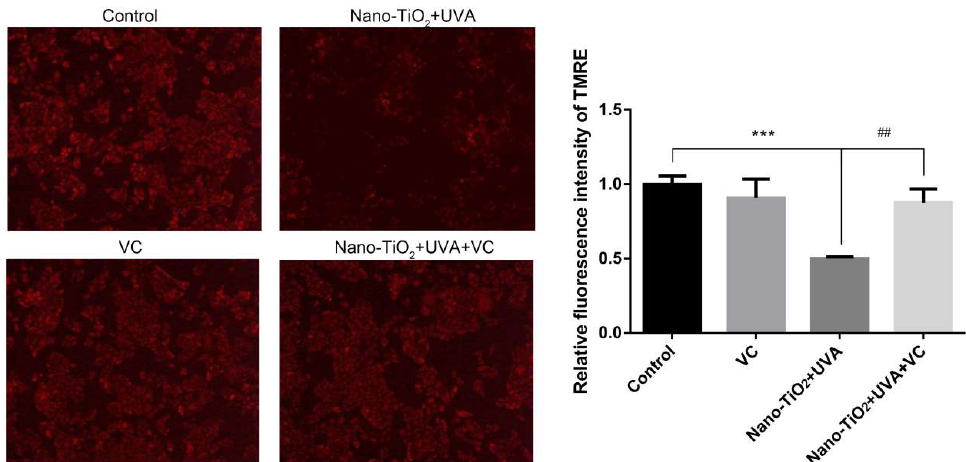
Figure 6. Mitochondrial permeability transition pore (mPTP) opening was relieved after inhibited ROS. HeLa cells were treated with 50 μg/mL nano-TiO 2 and UVA irradiation, or the combination of 0.4 mM VC, nano-TiO 2 and UVA irradiation. mPTP opening was detected by TMRE fluorescent staining. The fluorescence intensity of TMRE was statistically analyzed by Image J, n = 3, *** p < 0.001, compared with the control group; ## p < 0.01, compared with adding VC before and